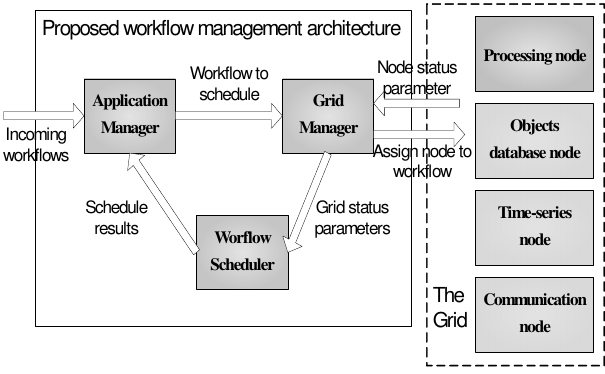
Fig. 3. Proposed architecture of the